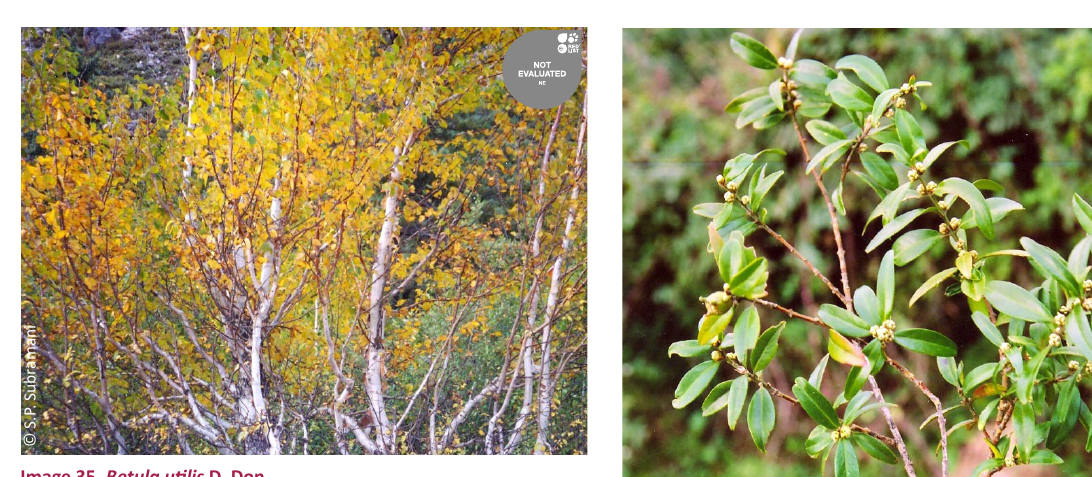
Image 35. Betula utilis D. Don